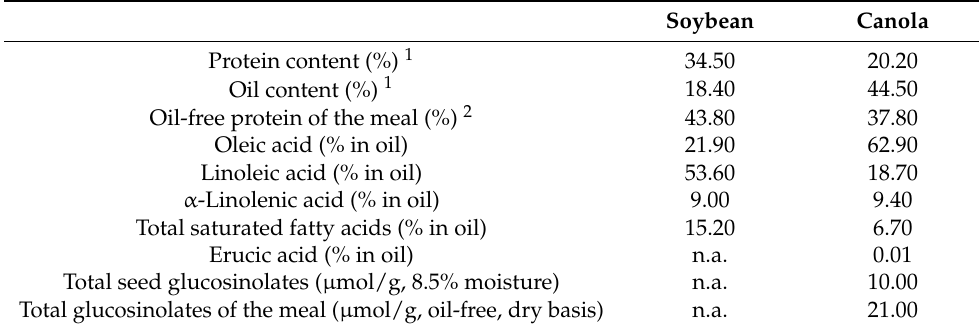
Table 1. Comparison of seed quality between Canadian soybeans and western Canadian canola presented as the average value of 2013–2017 crops, inclusive. Table compiled with soybean data [82] and canola data [81] published by the Canadian Grain Commission. Non-applicable measurements indicated with